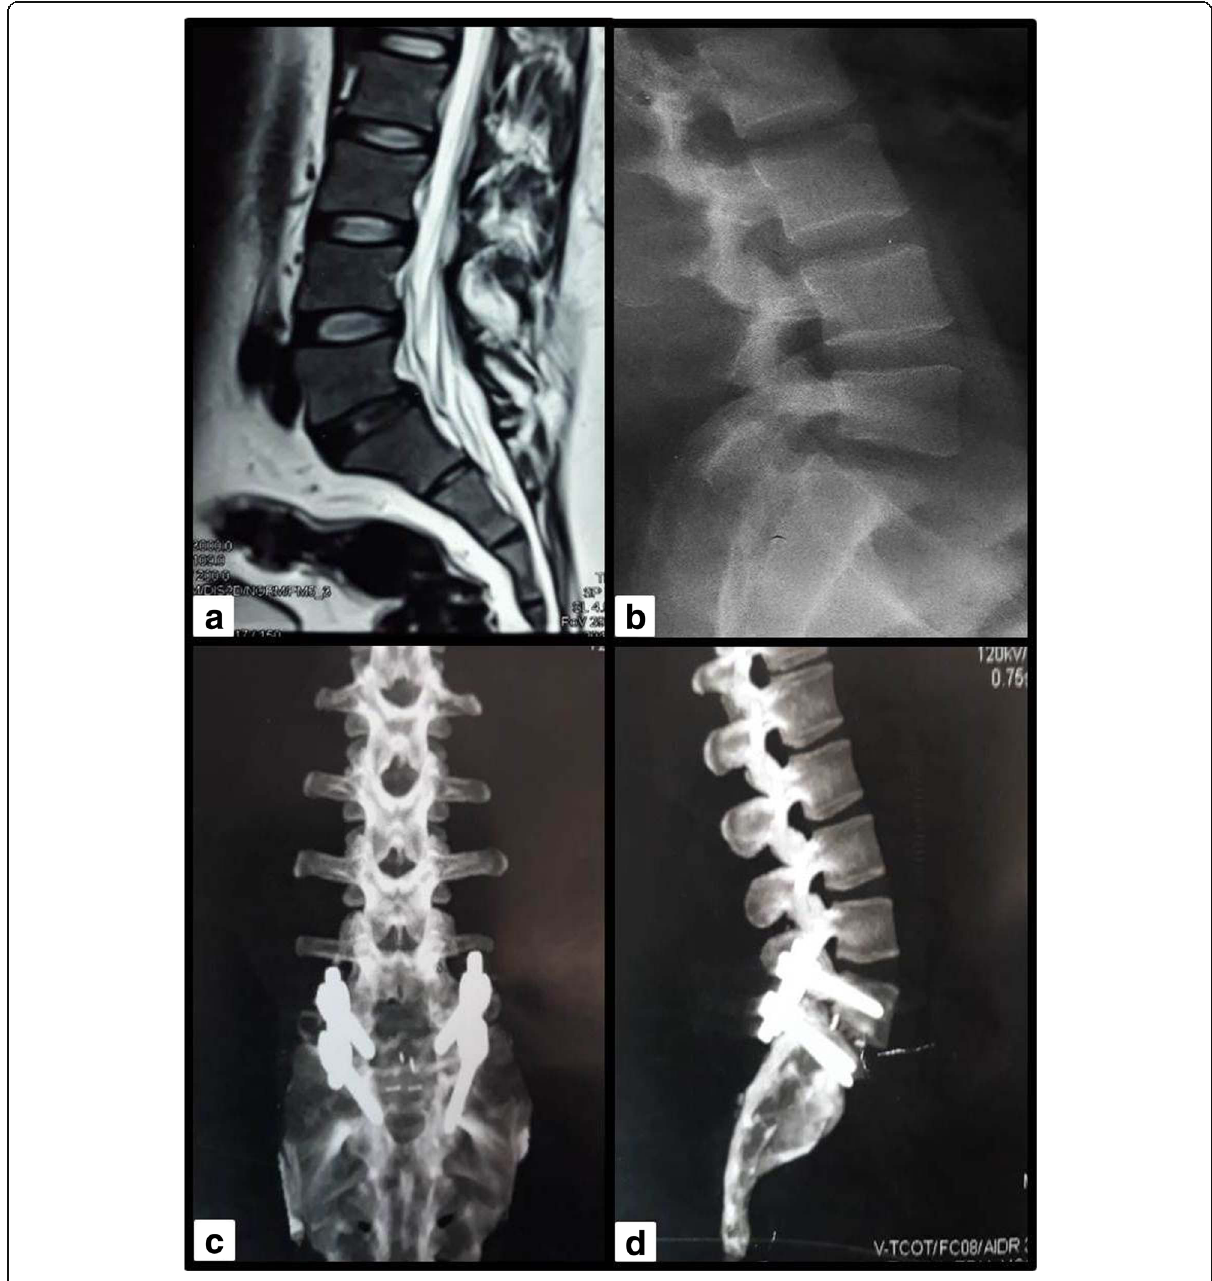
Fig. 3 PLIF procedure for the patient with degenerative L5 S1 spondylolisthesis. a Preoperative MRI. b Preoperative X-ray lateral view. c, d Posteroanterior and lateral X-ray films 6 months postoperatively. Note the reduction in the anterolisthesis and restoration of disk